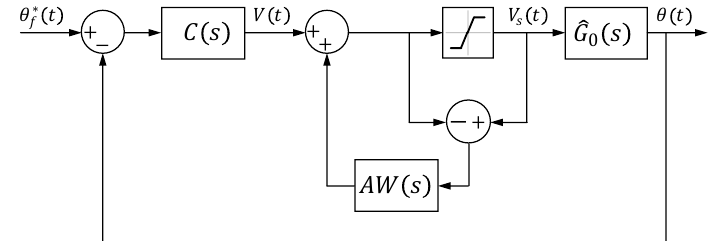
Figure 7. Antiwindup scheme.